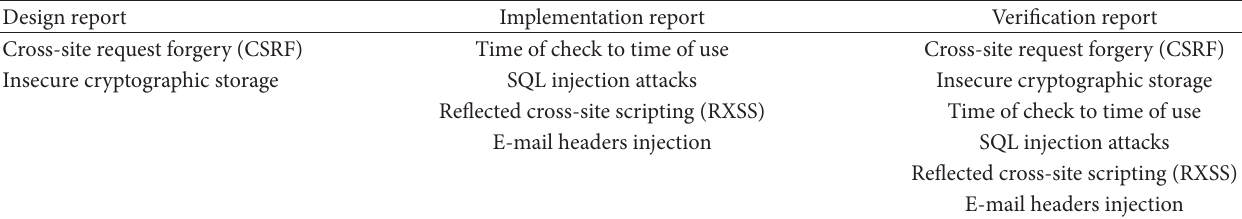
Figure 7: VOMS Admin risk analysis. Table 1: Vulnerabilities reported to be found in corresponding AutSEC